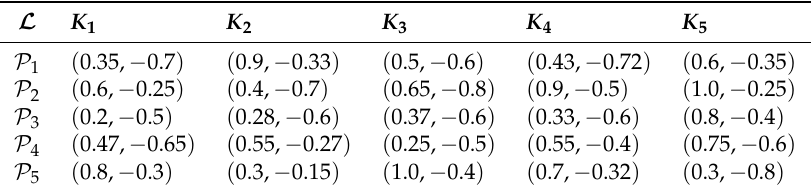
Table 1. Bipolar fuzzy decision